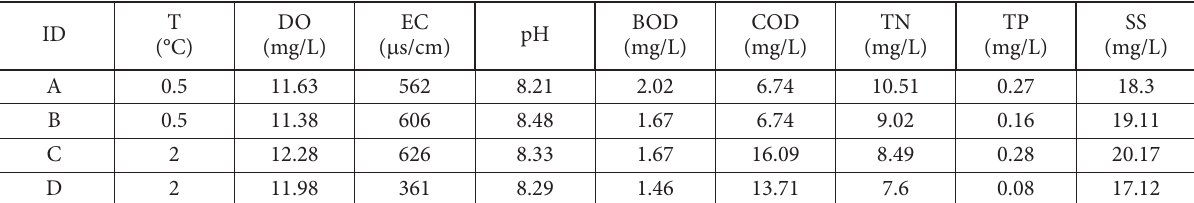
Table 5. Water quality parameters at four sites for one instance of sample